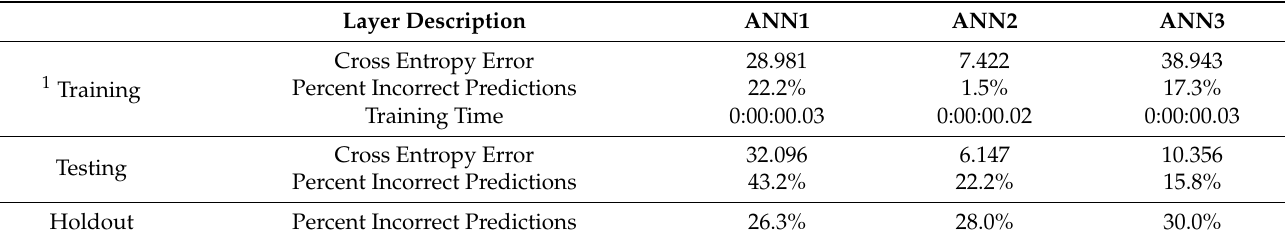
Table 5. Summary for designed models.